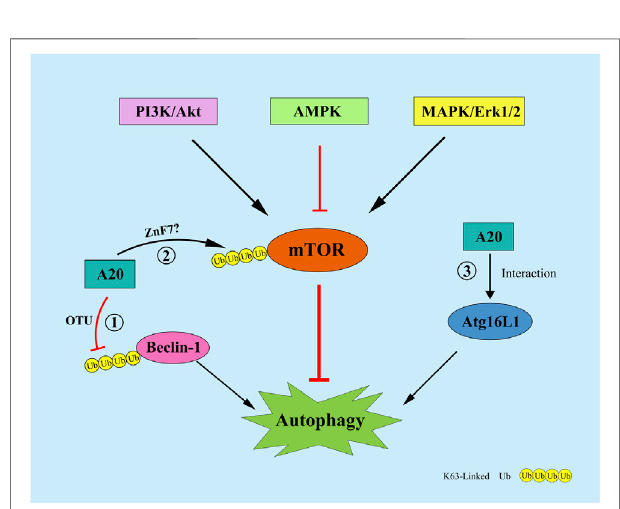
FIGURE 4 | A20 can regulate autophagy by the following mechanisms: ① A20 remove the K63-Linked polyubiquitin chains of Beclin1 through its OTU domain; ② A20 affect the ubiquitination level of mTOR through its ZnF7 domain; ③ A20 interact with ATG16L1 to regulate autophagy.